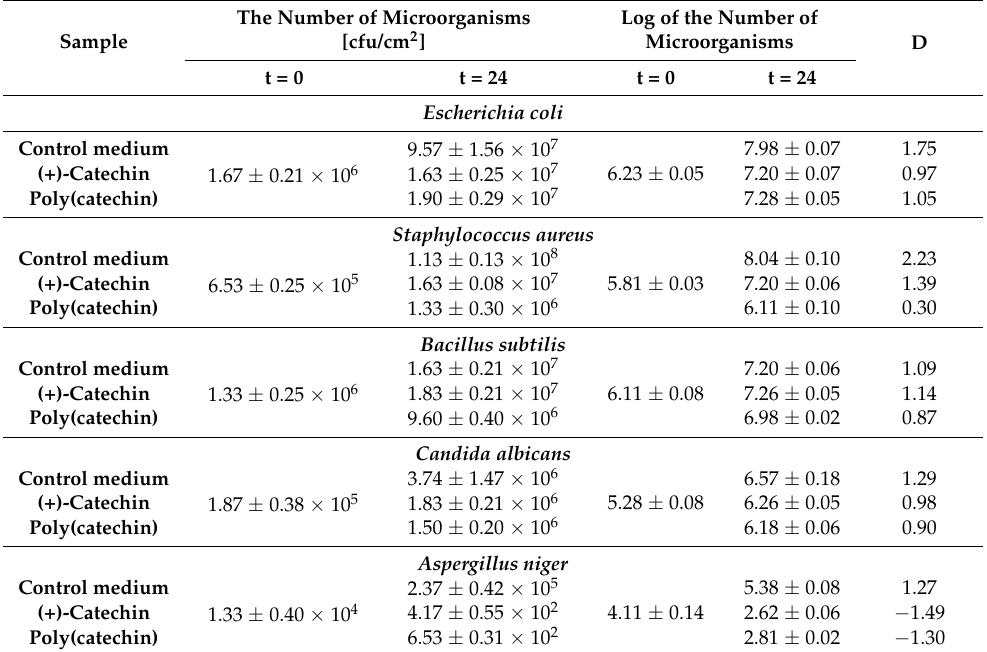
Table 3. Antibacterial and antifungal activity of (+)-catechin and poly(catechin).